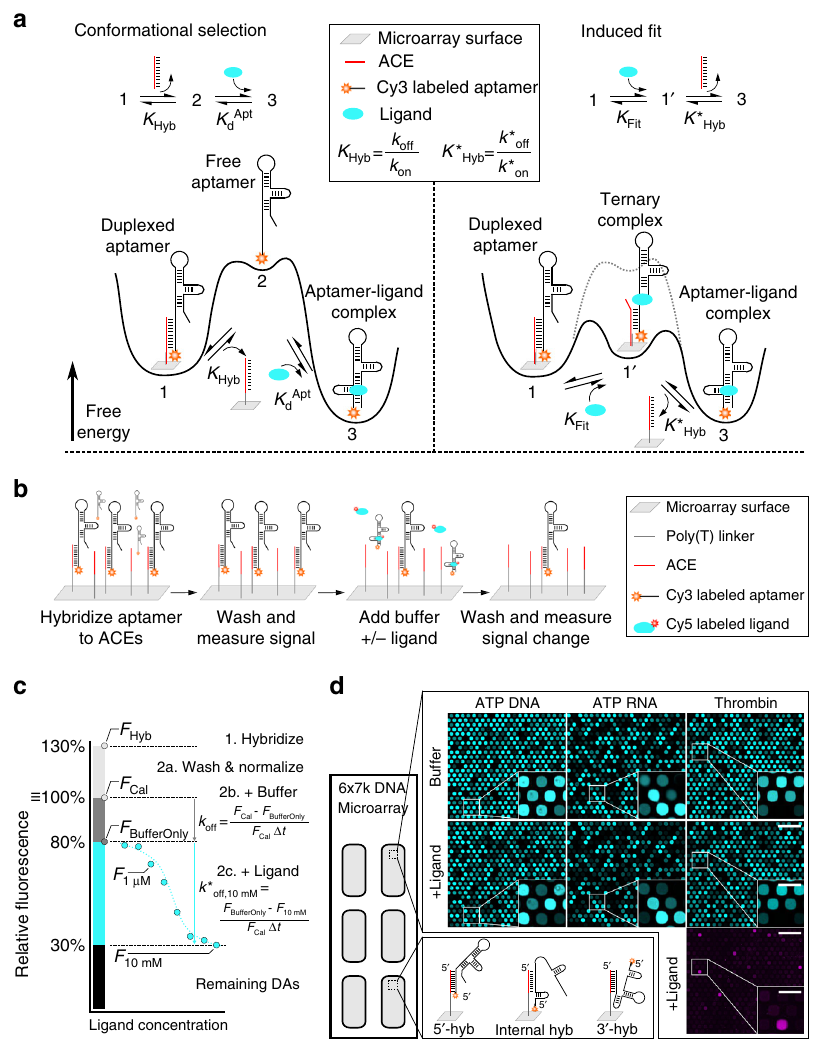
Fig. 1 ACE-Scan comprehensively pro fi les the ligand-binding landscapes of duplexed aptamers. a Free energy landscape of a surface DA following conformationally selective (left) or induced fi t ligand binding (right, conformational selection pathway shown as dotted gray line). Induced fi t binding relies on ligand recognition by the ACE-duplexed aptamer, further implying that the hybridized ACE may actively participate in the ternary DA-ligand-binding interaction. b ACE-Scan work fl ow. 1000 ’ s of ACEs synthesized on a DNA microarray were fi rst hybridized with the aptamer, and the fl uorescence intensity ( F Hyb ) was imaged to assess the hybridization af fi nity ( K Hyb ) of each ACE. Sub-arrays were either left unincubated (Calibration), incubated with buffer (BufferOnly), or incubated with varying ligand concentrations ( + [Ligand]), and changes in fl uorescence were recorded. c Schematic of relative fl uorescence signals obtained from ACE-Scan. F fi ned as 100% for each DA (see Methods section), and changes in relative fl uorescence after 1 h Cal was de ( Δ t ) were used to calculate k off (spontaneous duplex dissociation rate, units of h − 1 ), k * off (induced fi t duplex dissociation rate, units of h − 1 ) and K Fit (induced fi t binding af fi nity, units of M). Representative ACE-Scan relative fl uorescence values for F F Hyb and BufferOnly are plotted, and a representative dilution curve for 8 ligand concentrations is shown in cyan, with two fl uorescence signals labeled ( F 1 µ M , F 10mM ). Importantly, DA dissociation rates in ACE-Scan are a sum of k off and k * off[Ligand] rates, and k * off[Ligand] is therefore calculated based on the increased dissociation rate, relative to k off , induced by the presence of ligand 15 . d Representative ACE-Scan images for three in vitro-selected aptamers (ATP DNA, ATP RNA, and thrombin DNA aptamers). Top row of panels: Cy3 fl uorescence measured after buffer-only incubation for 1 h ( F BufferOnly ). Middle row of panels: Cy3 fl uorescence measured after 10 mM ATP ( F 10mM ) or 2 µ M thrombin ( F 2 µ M ) incubation for 1 h. Bottom right panel: red fl uorescence of AF647-labeled thrombin bound to thrombin DAs after incubation with 2 µ M thrombin for 1 h. Scale bars: 300 µ m (large panels) and 100 µ m (insets). Bottom left panel: schematic of DAs engineered with 5 ʹ -, 3 ʹ - and